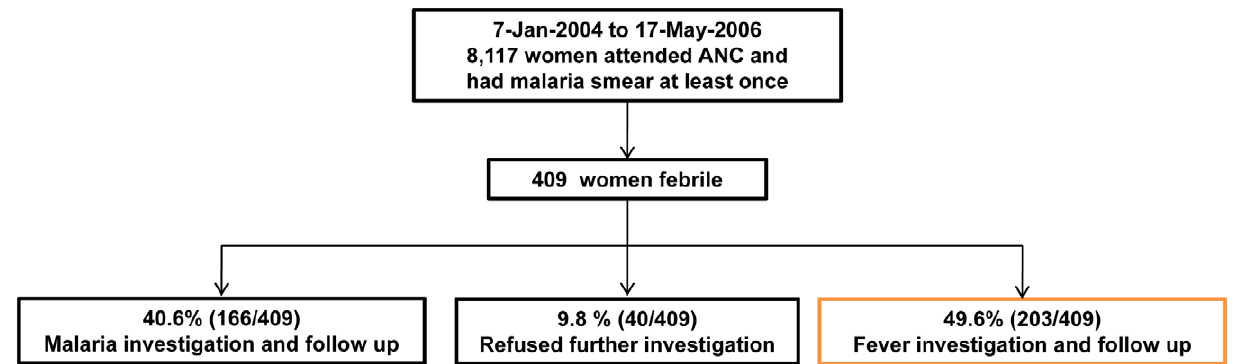
Figure 2. Patient flow.